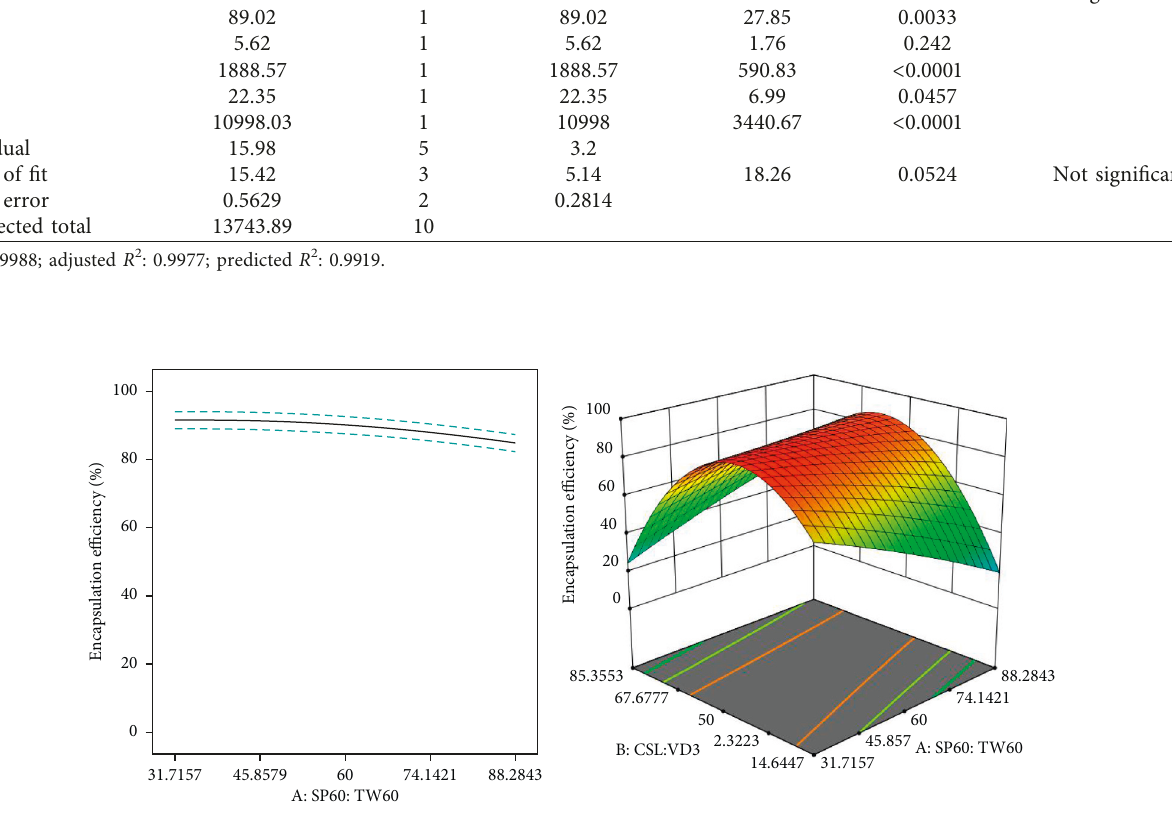
Table 4: Estimated coefficients of multiple determinations ( R 2 ) for encapsulation efficiency using coded values. Source Sum of